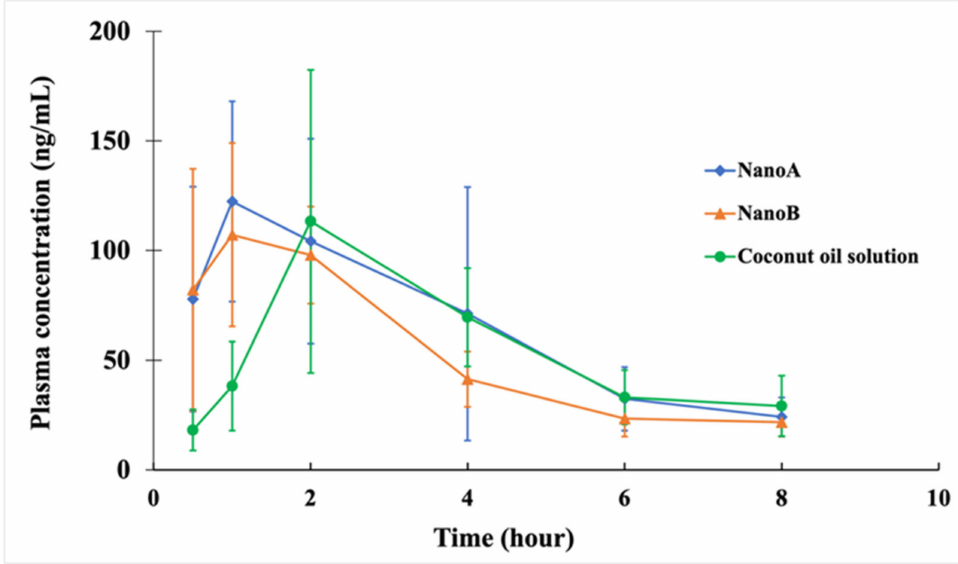
Figure 6. Plasma concentration–time curve of the coconut oil solution ( n = 6) and NanoA and NanoB suspensions ( n = 6) after oral administration in Sprague–Dawley rats at a dose of 5 mg/kg. The C max values for NanoA (0.13 ± 0.05 mg L − 1 ), NanoB (0.12 ± 0.03 mg L − 1 ), and coconut oil solution (0.12 ± 0.07 mg L − 1 ) were nearly the same. The T max or time for C max was faster with NanoA (1.58 ± 1.28 h) and NanoB (1.08 ± 0.49 h), compared with the coconut oil solution (2.33 ± 0.82 h). The bioavailability values of NanoA and NanoB suspensions following oral administration were 28.6% and 22.7%, respectively, which were comparable to the coconut oil solution (28.4%), in which CCG-211790 had good